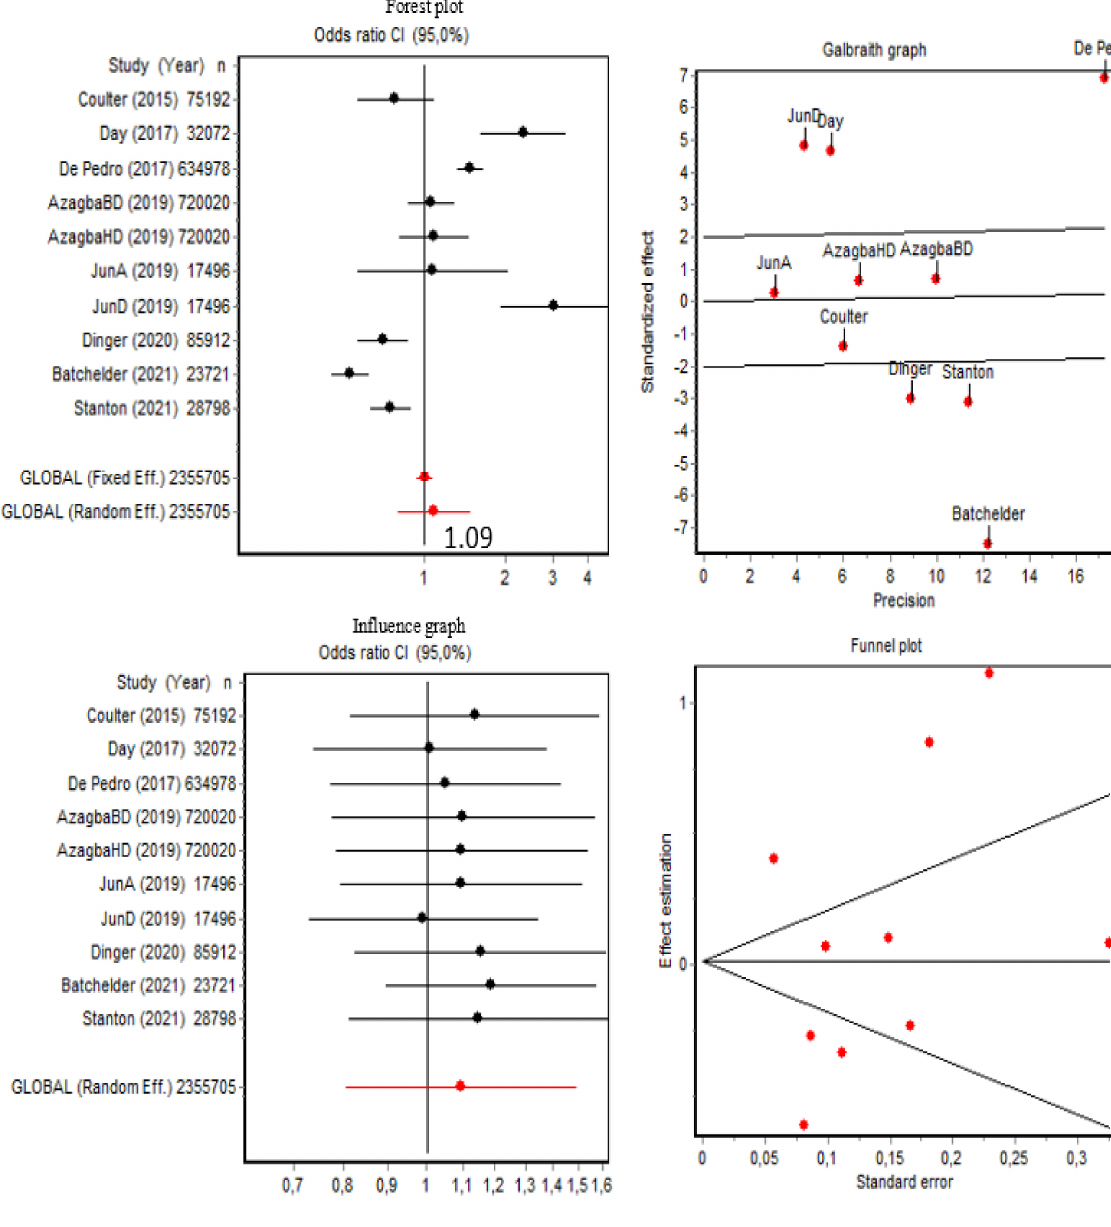
Figure 4. Forest plot, Galbraith graphic, influence graphic, and funnel plot for current alcohol use disorder. Abbreviations: BD, binge drinking; HD, heavy drinking; A, abuse; D,